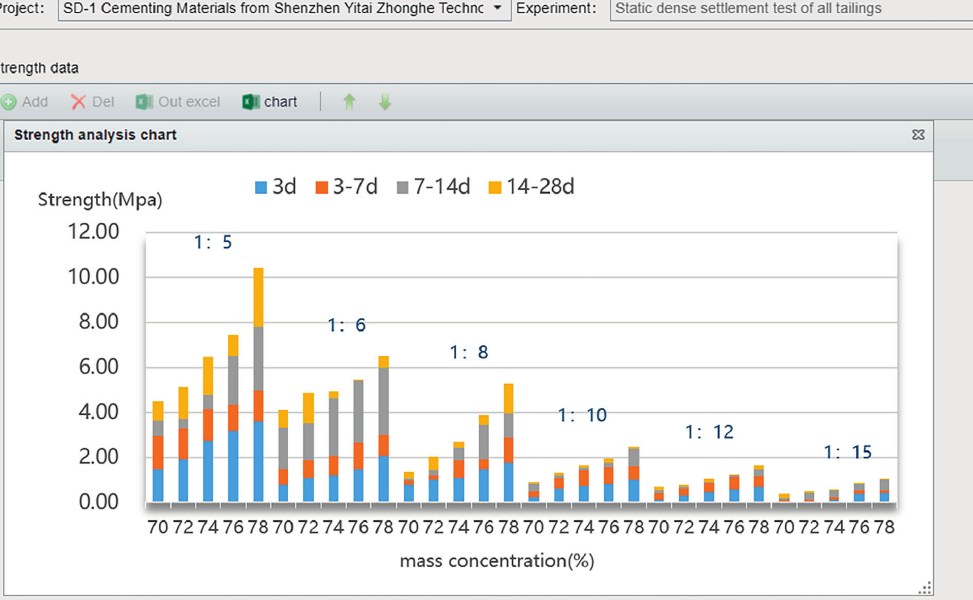
Figure 7: Strength analysis chart